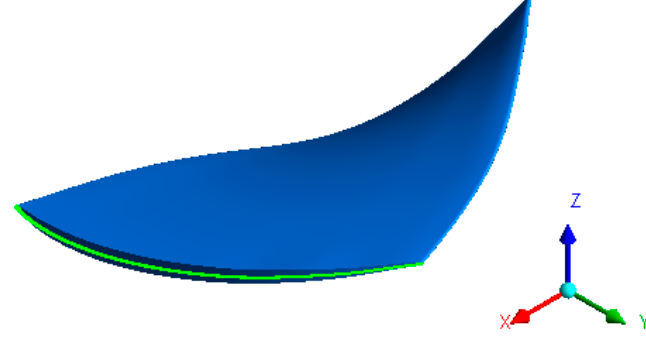
Figure 19. View of the selected plane along the blade chord direction at the tip.